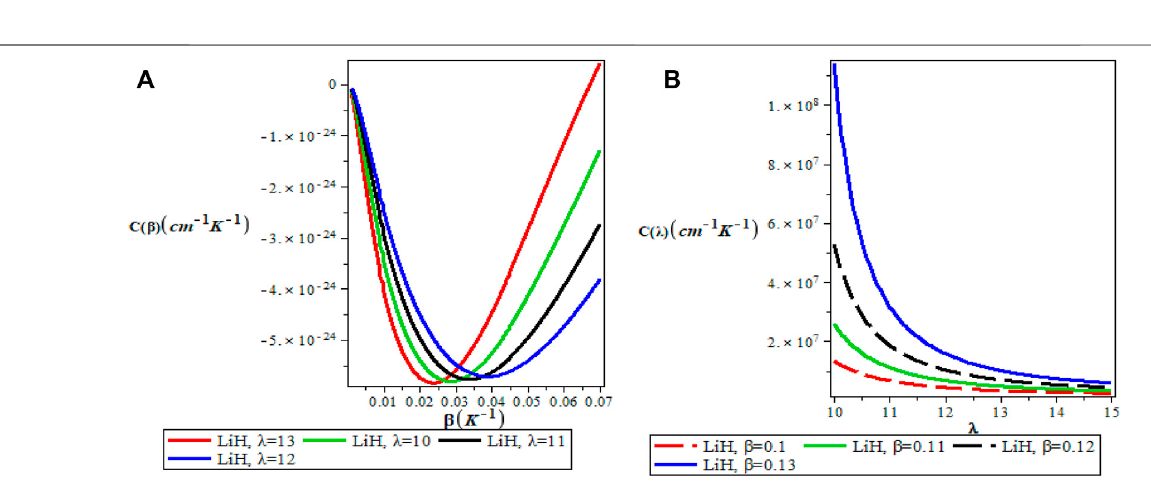
FIGURE 7 | (A) Variation of Speci fi c Heat Capacity With Respect to β (B) Variation of Speci fi c Heat Capacity With Respect to λ .